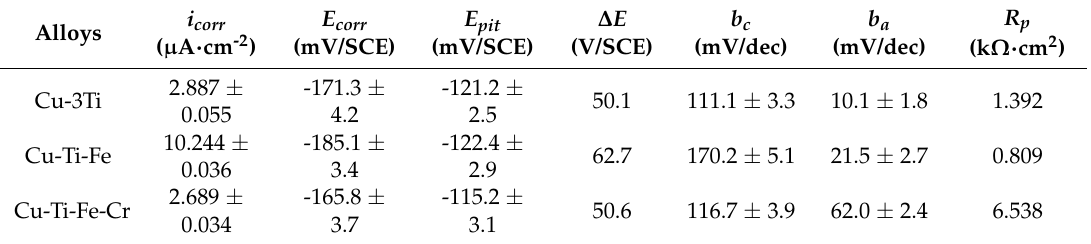
Table 4. Polarization parameters of the three alloys aging, at 450 ◦ C, for the peak-aging times. ∆ E R p i corr E corr E pit b c b a Alloys ( µ A · cm -2 ) (mV/SCE) (mV/SCE) (V/SCE) (mV/dec) (mV/dec) (k Ω · cm 2 ) 2.887 Cu-3Ti